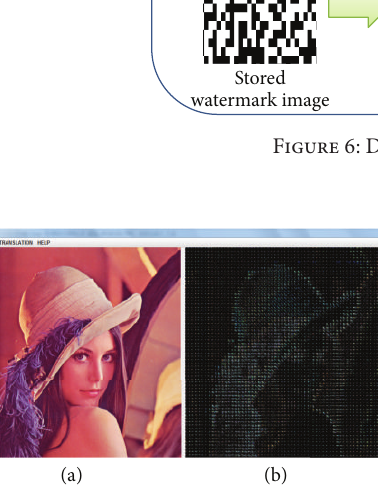
Figure 7: Screen for original image (a) and 8 × 8 DCT image (b).